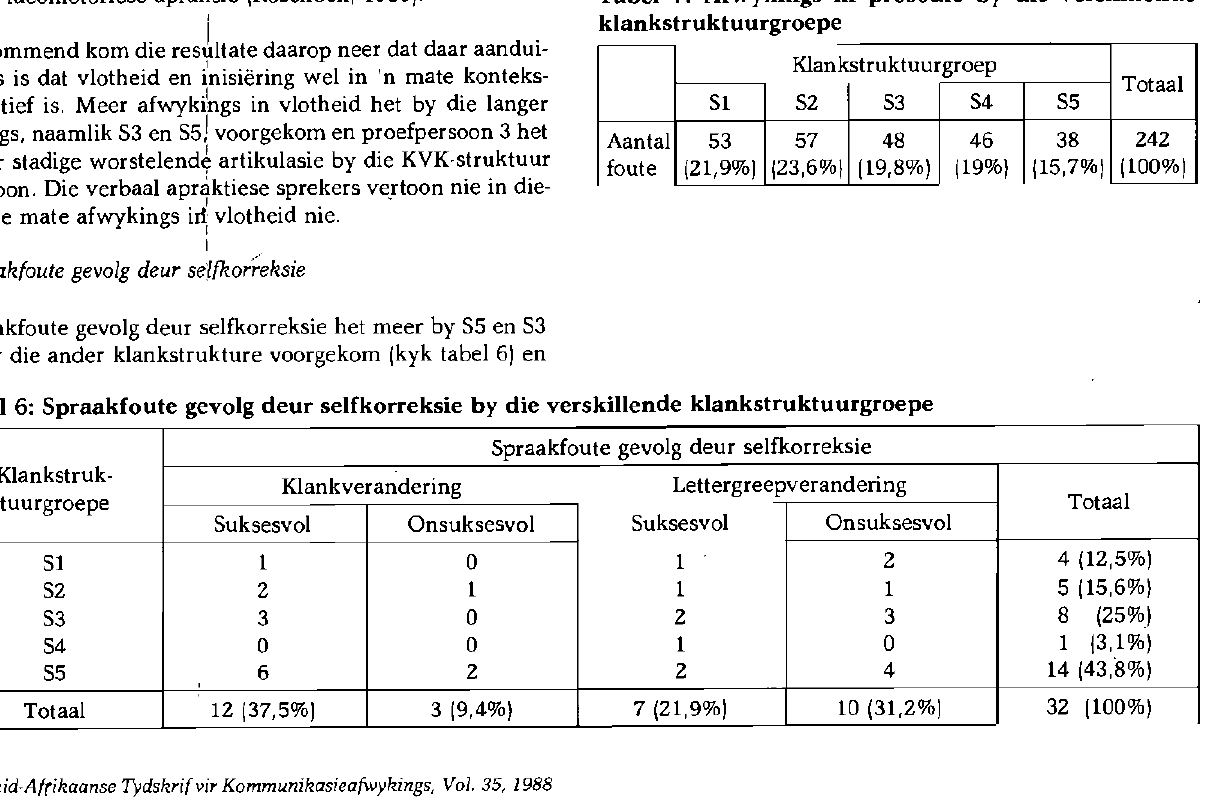
Tabel 7: Afwykings in prosodie by die verskillende klankstruktuurgroepe